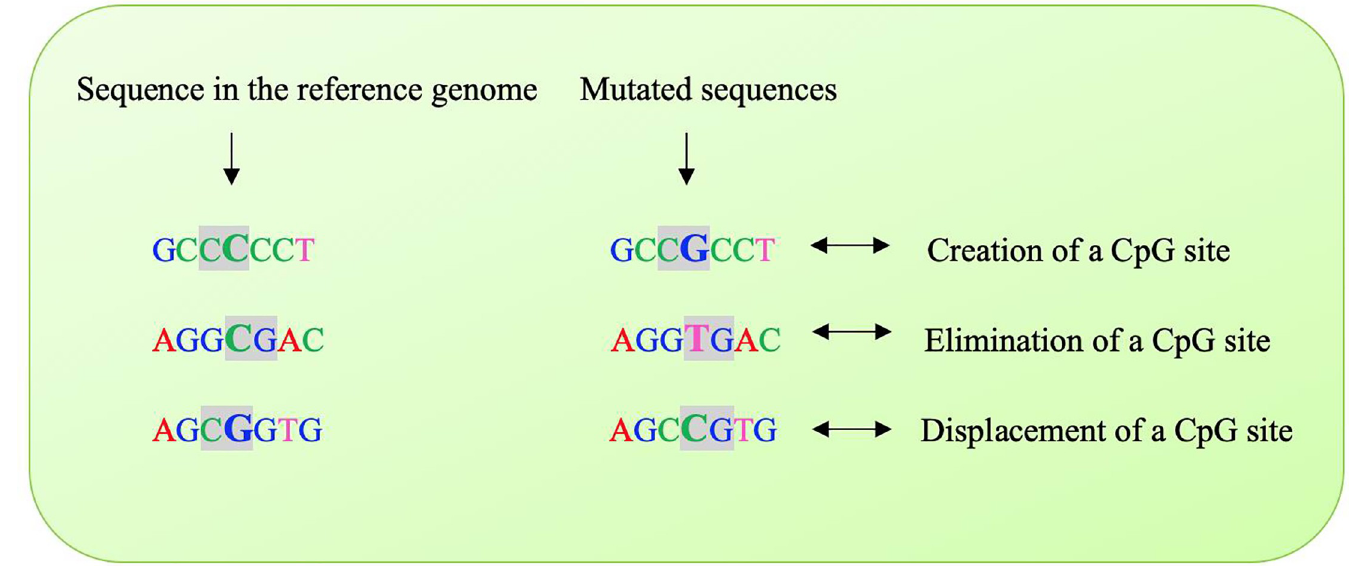
Fig 1. Examples of variants caused by meSNP. The modification caused by a meSNP can create, destroy or displace a CpG site, the disruption of these sites can drastically change the methylation state. Base in bold represents a meSNP.